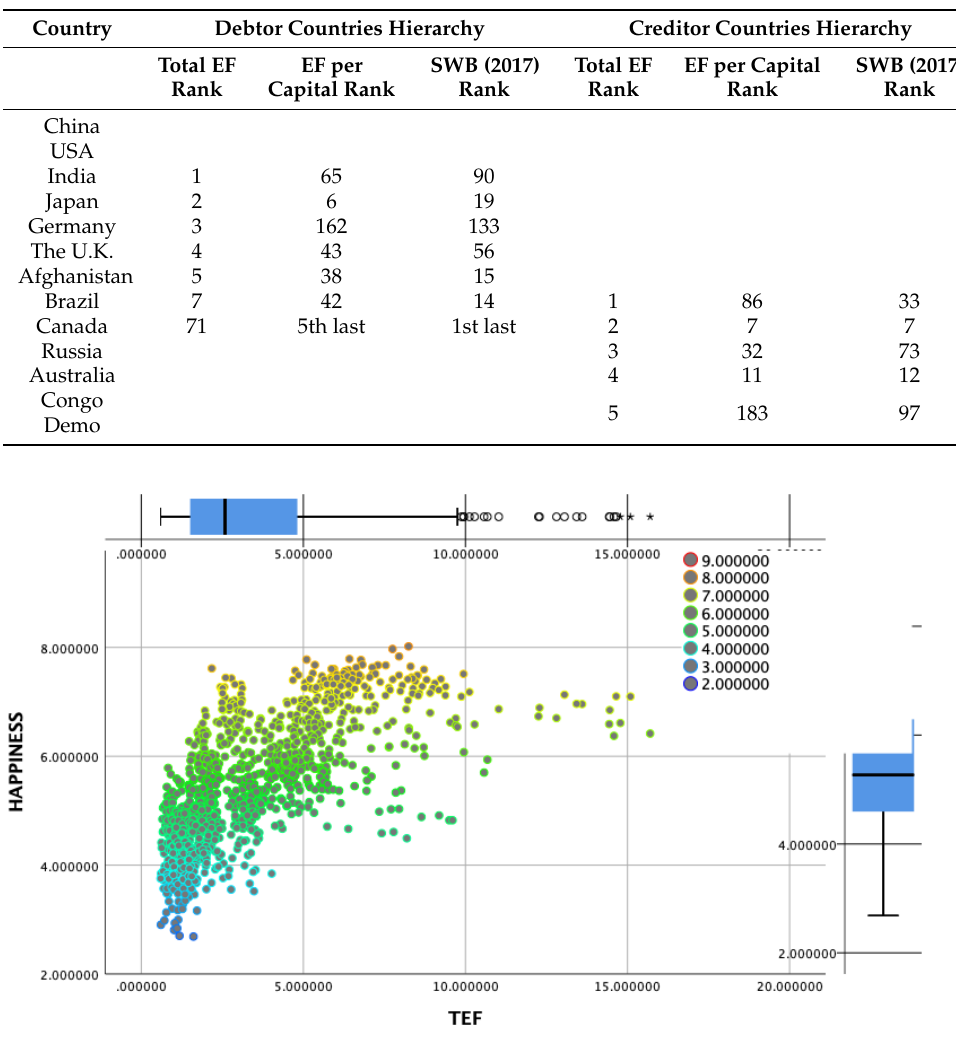
Figure 3. Correlation Between EF and SWB. Note: Above picture was taken by IBMSPSS Statistics, IBM Corp. Released 2020. IBM SPSS Statistics for Windows, Version 27.0. Armonk, NY, USA: IBM Corp